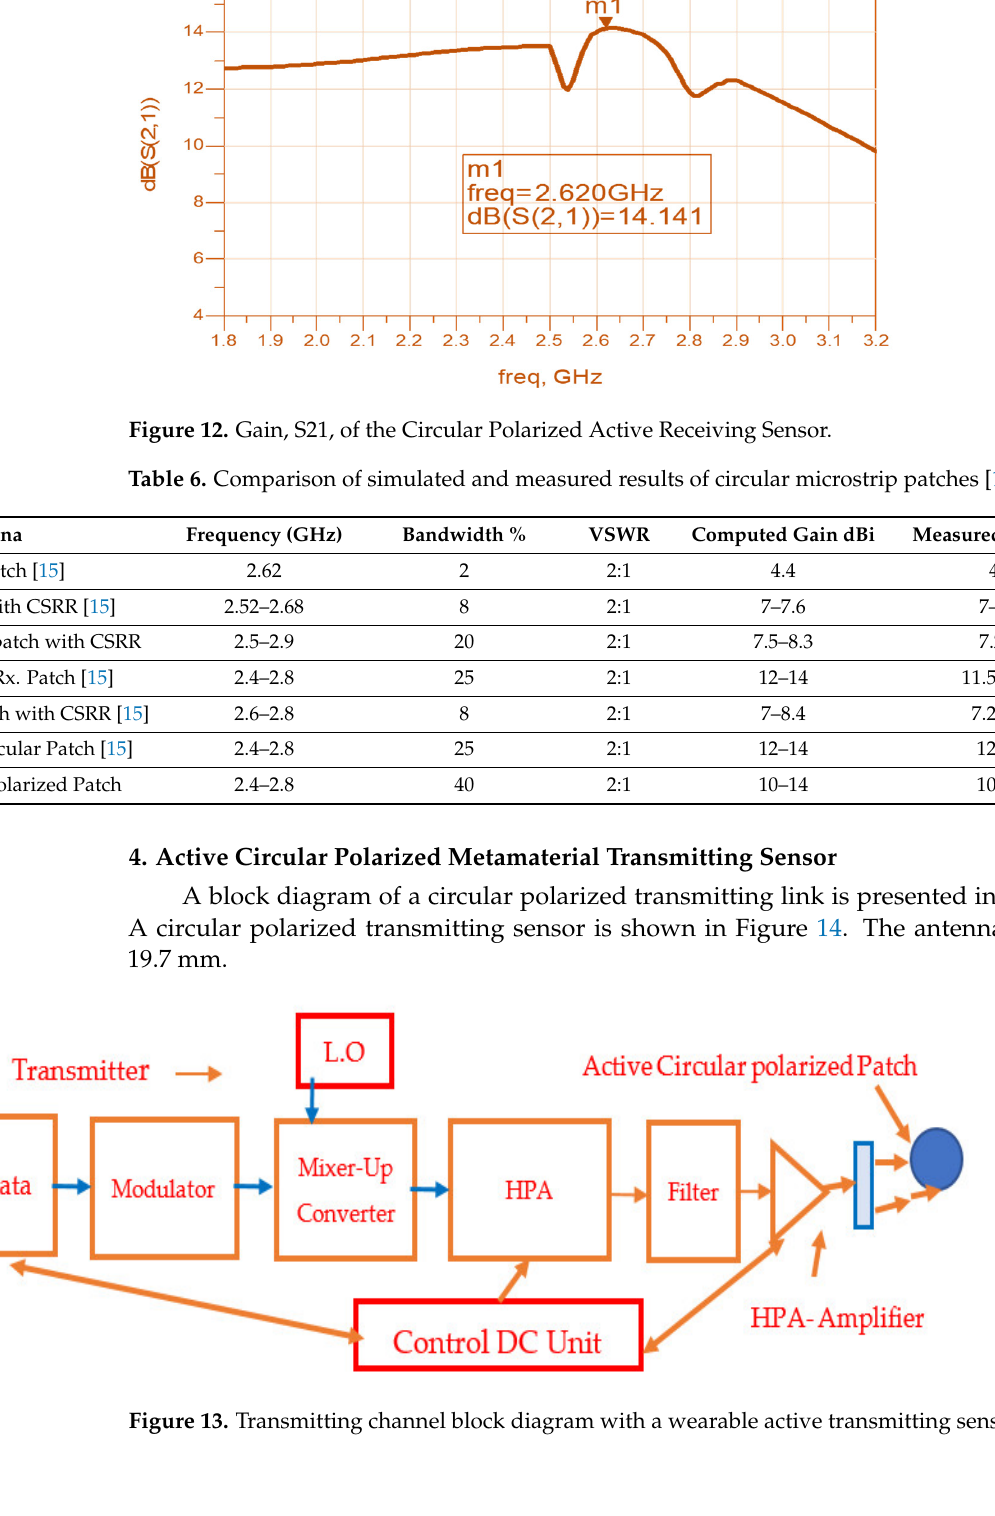
Figure 11. Matching network of the circular polarized active receiving sensor.